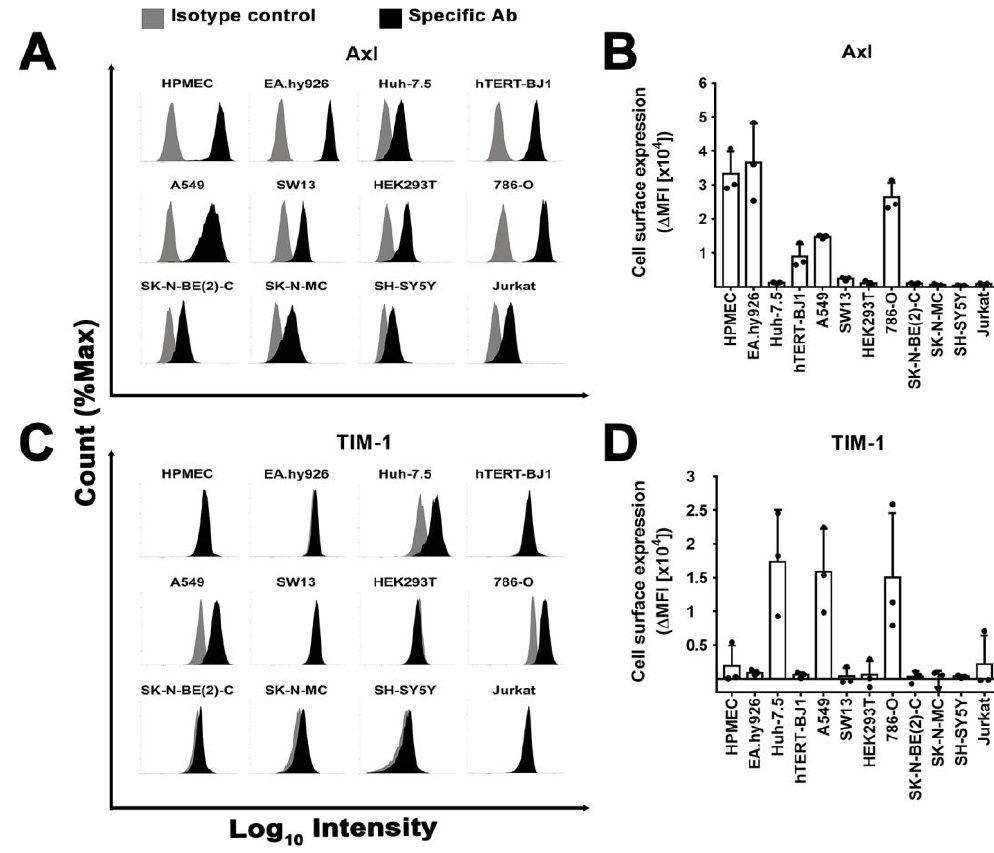
Figure 7 . Surface expression does not explain susceptibility to filovirus infection. ( A–D ) Axl and TIM-1 cell surface expression. Cells were surface stained with saturating concentrations of specific abs and their correspondent isotype controls and fluorescent signal quantified by flow cytometry. Protein expression profiles of ( A ) Axl and ( C ) TIM-1 in different cell lines are shown as histograms of a representative experiment. ( B–D ) Cell surface expression of Axl and TIM-1 in terms of average delta mean fluorescence intensity (ΔMFI) from three independent stainings. ΔMFI was calculated by subtracting the geometric mean intensity values of the isotype control from the specific staining values. SD is shown as error bars.